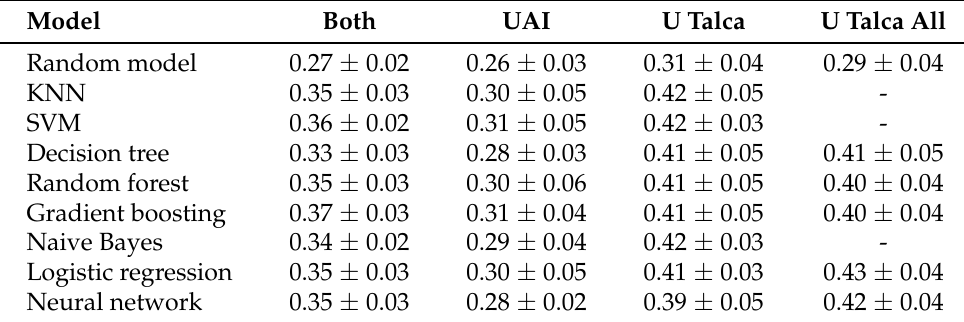
Table 2. F 1 score + class, for each dataset.